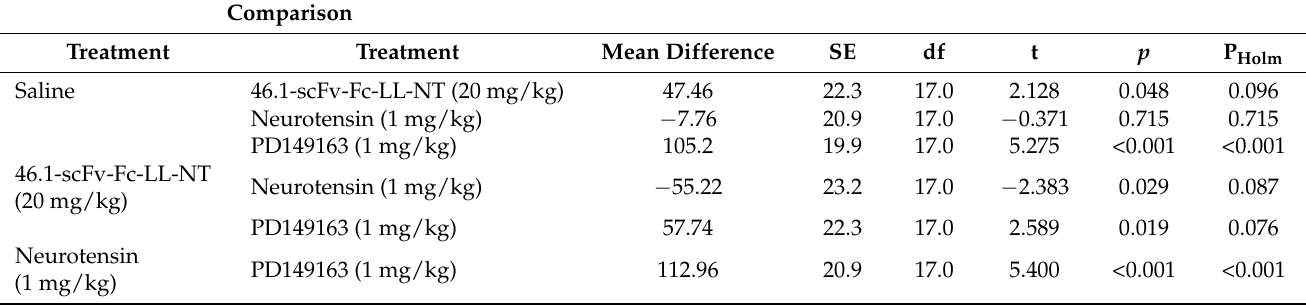
Table 1. The statistical parameters for mixed ANOVA analysis of PCP-induced hyperlocomotion.